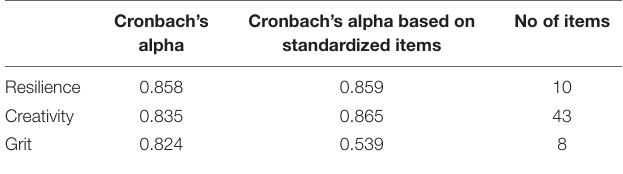
TABLE 1 | Reliability statistics of the